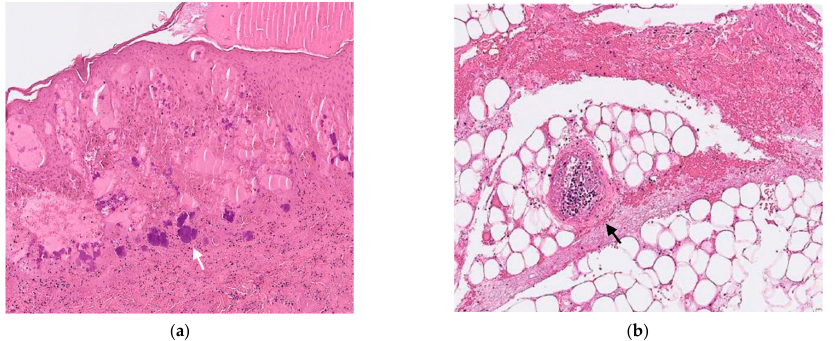
Figure 2. The pathologic images (Gram stain, ×200) of the incisional biopsy of the papulonodular skin lesion reveal ( a ) aggregates of Gram-positive cocci (white arrow) at subepidermal area and ( b ) necrotic vasculitis (black arrow) without perivascular bacterial invasion (Hematoxylin and Eosin stain, ×200).